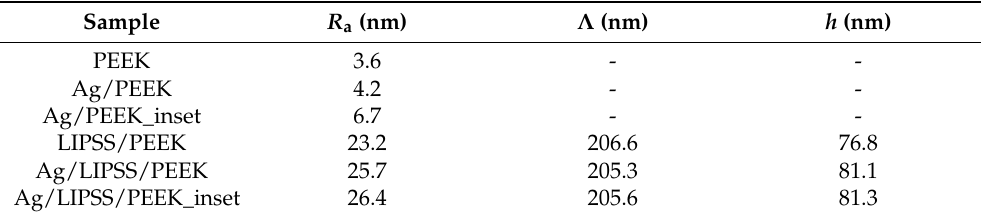
Table 1. Summary of surface characteristics derived from AFM analysis: surface roughness ( R a ), periodicity ( Λ ), and height ( h ).